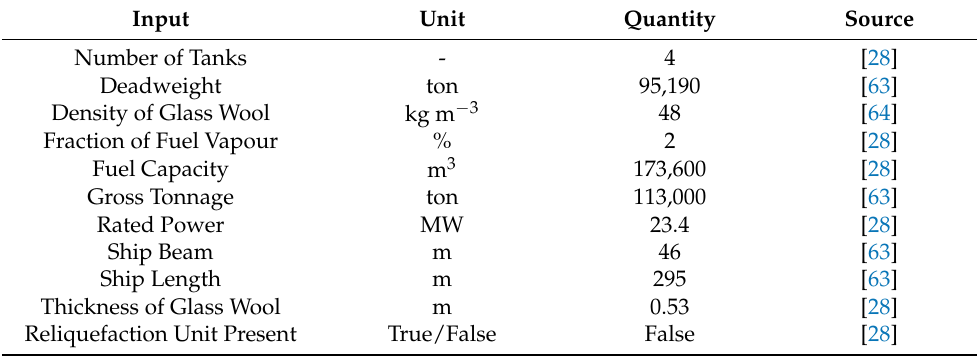
Table 1. Data for the conventional LNG ship [28,63,64].